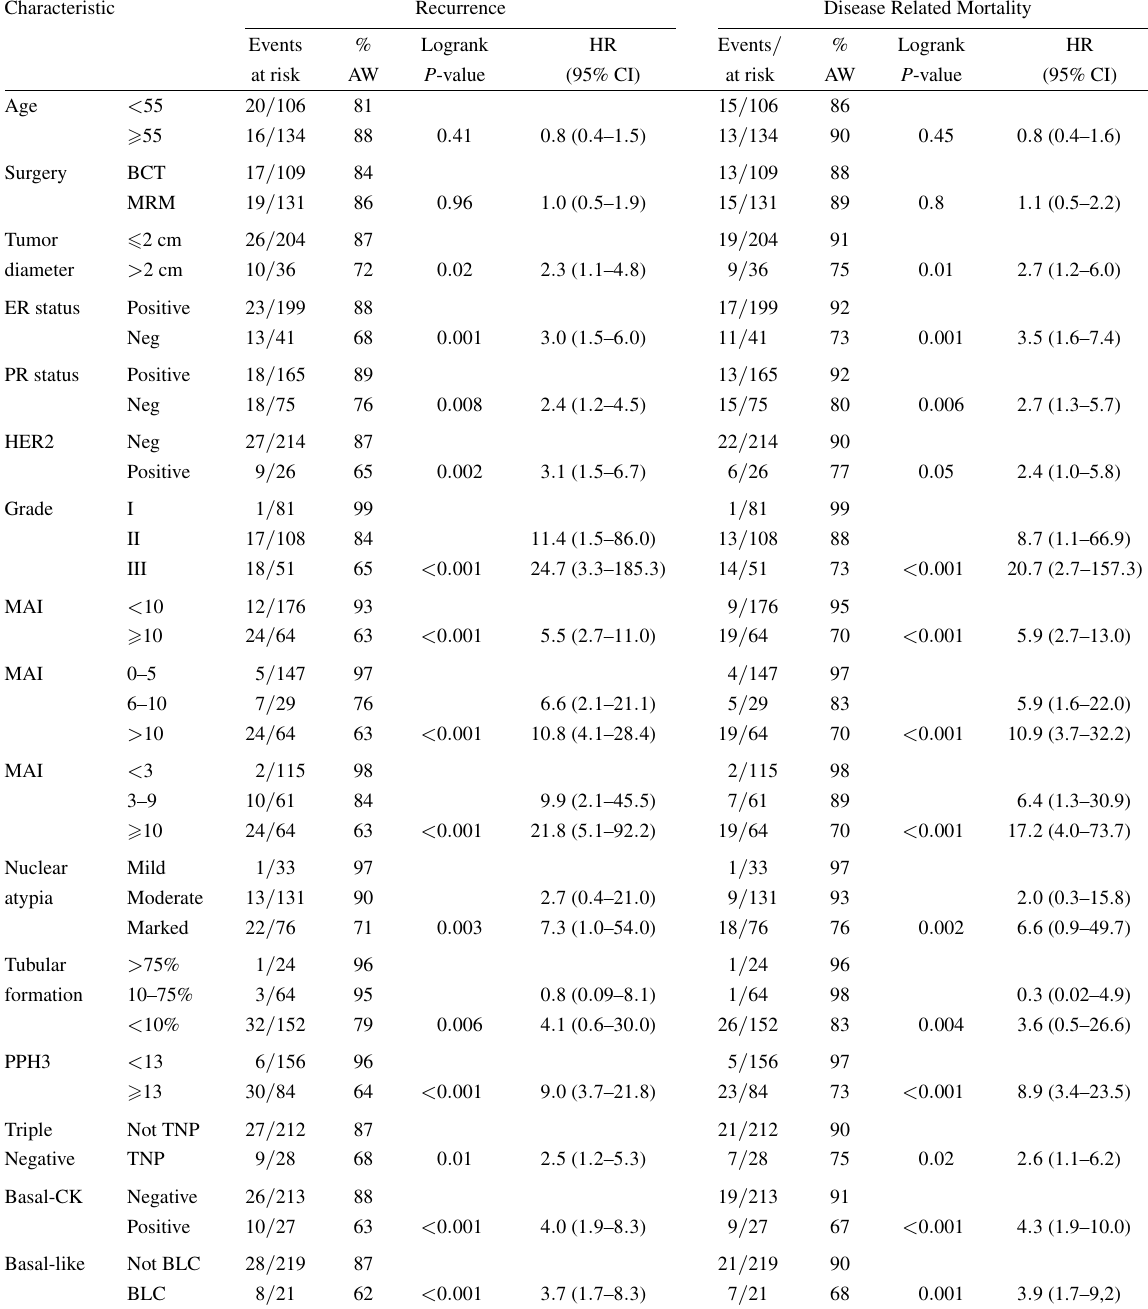
Prognostic value (long-term, recurrence-free survival and Disease Related Mortality) of clinicopathologic features, MAI, steroid receptors, and PPH3